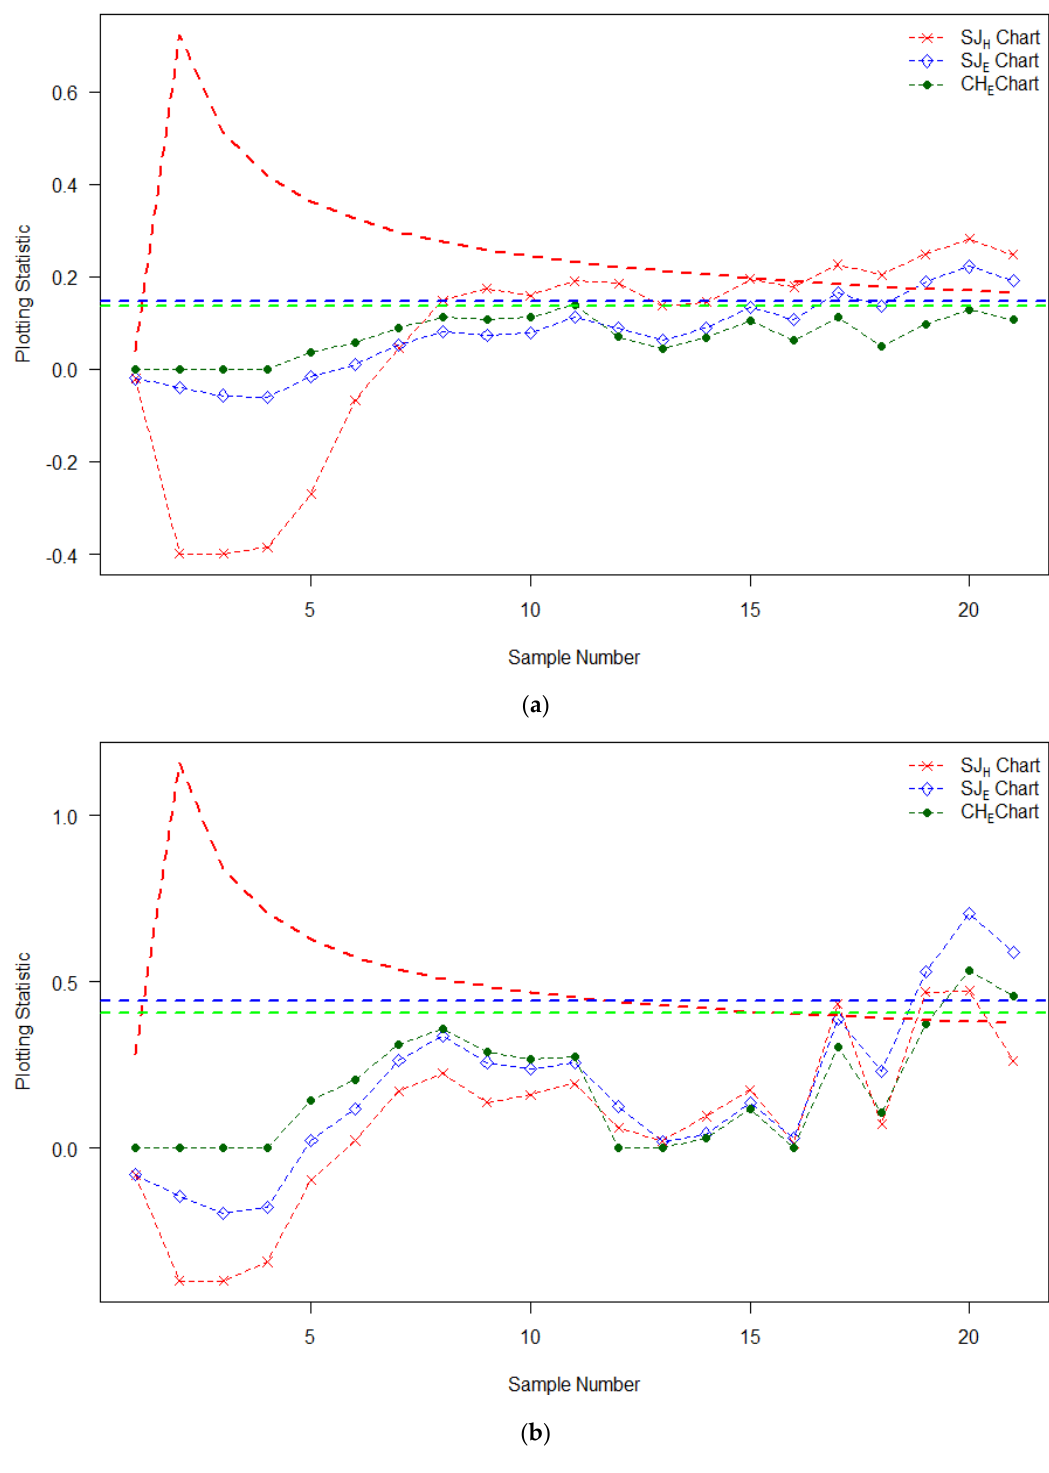
Figure 7. An application based on the wind farm data: ( a ) 𝜆 = 0.05 , ( b ) 𝜆 = 0.2 .